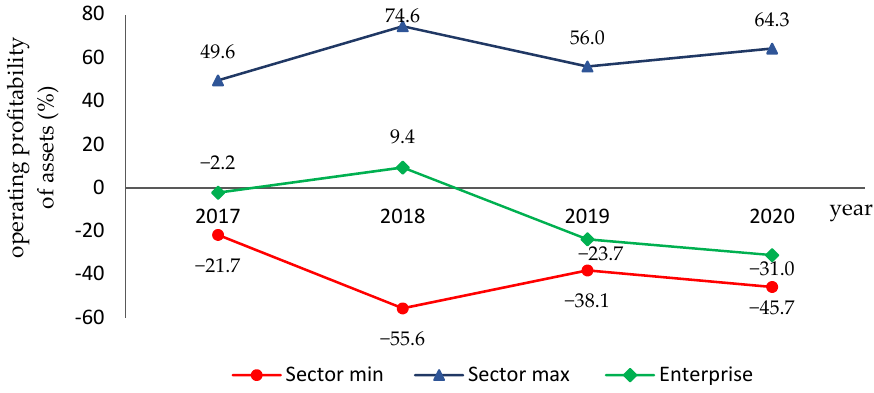
liquidity ratios indicate low coverage of current liabilities with current assets. The litera ‐ ture states that the current ratio ( y 4 ) should be within 1.2–2 and the quick ratio ( y 5 ) should be in the range of 1–1.2 [52,53]. In the case of the surveyed company, obtained values of both indicators were below the reported ranges (Figures 7 and 8). The data also show that liquidity as measured by current and quick ratios was weaker than in other entities of the studied sector. Figure 5. Profit margin ratio ( y 1 ) in the enterprise and in the sector in 2017–2020 (%). The obtained results, in comparison with the values achieved in the entire sector, indicate that the studied company achieved relatively low profitability in the year 2018.